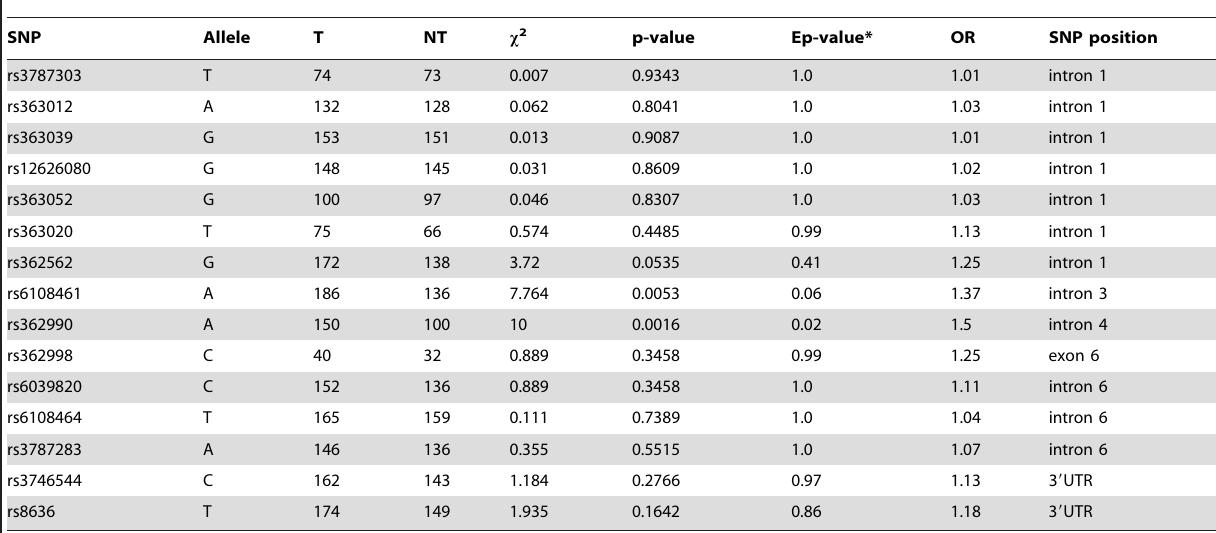
Table 1. TDT analysis of SNAP25 polymorphisms in ADHD nuclear